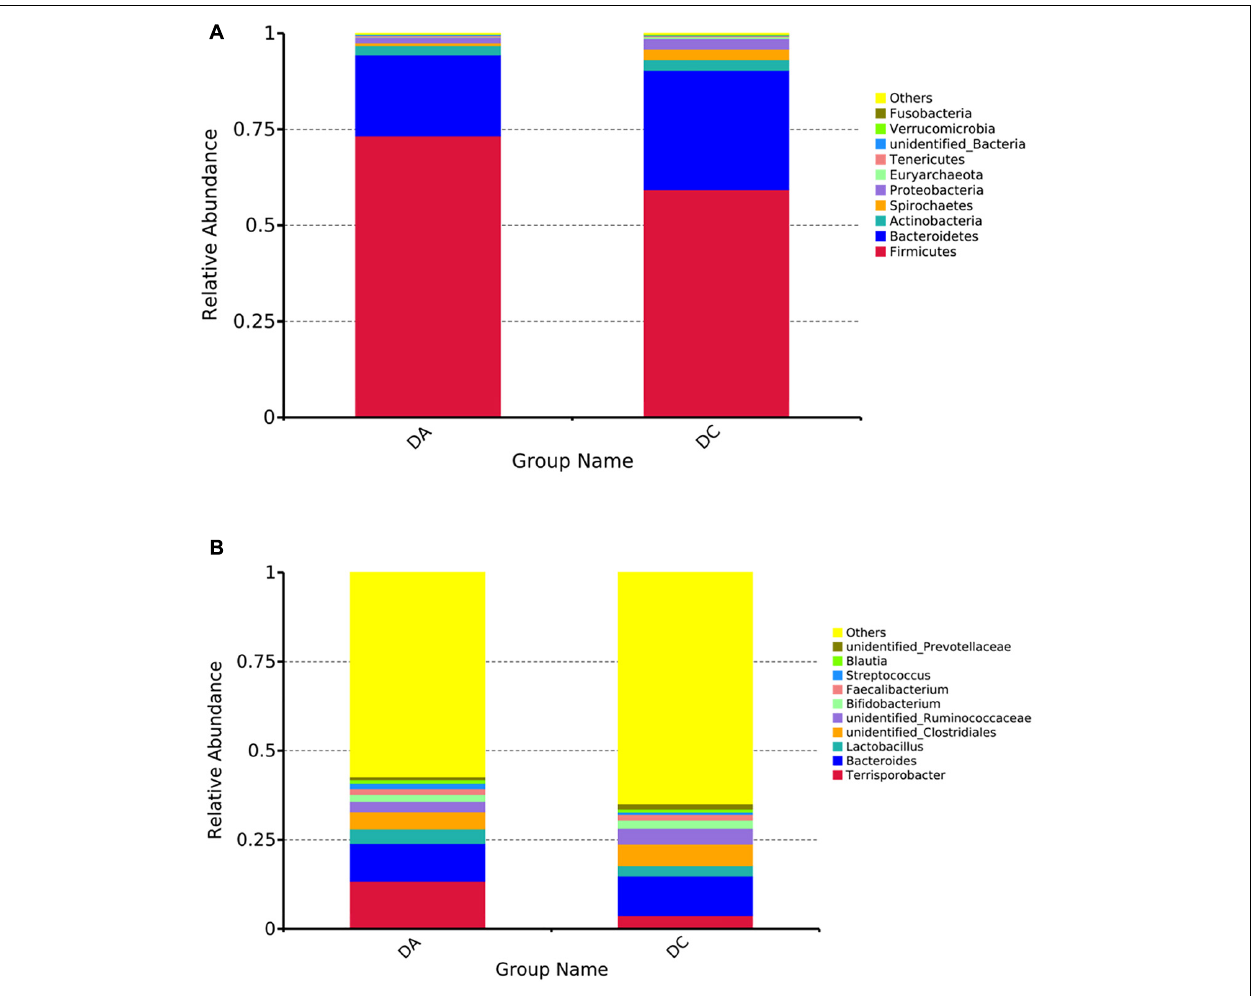
FIGURE 2 | The histogram of relative abundance for intestinal microbiota in Diannan small ear sows (select the top 10 microbes at each level). (A) Phylum level, (B) genus level.